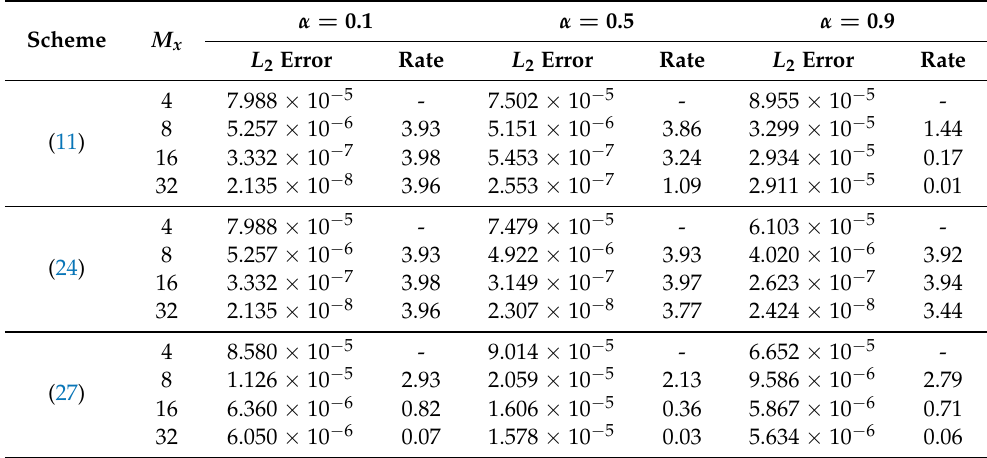
Table 4. The L 2 -norm errors in space for non-smooth case in Example 1 with τ = T /8192, ϑ = α , κ = 1, r = 0.06, D = 0, and σ =